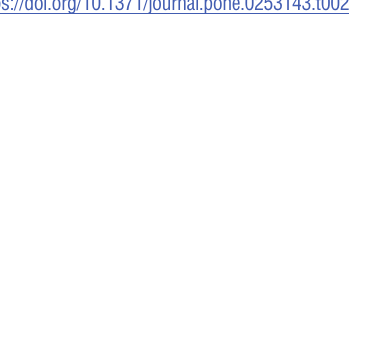
Table 3. The subgroup analysis of laparoscopic types between MIS and ORH in intraoperative and postoperative overall